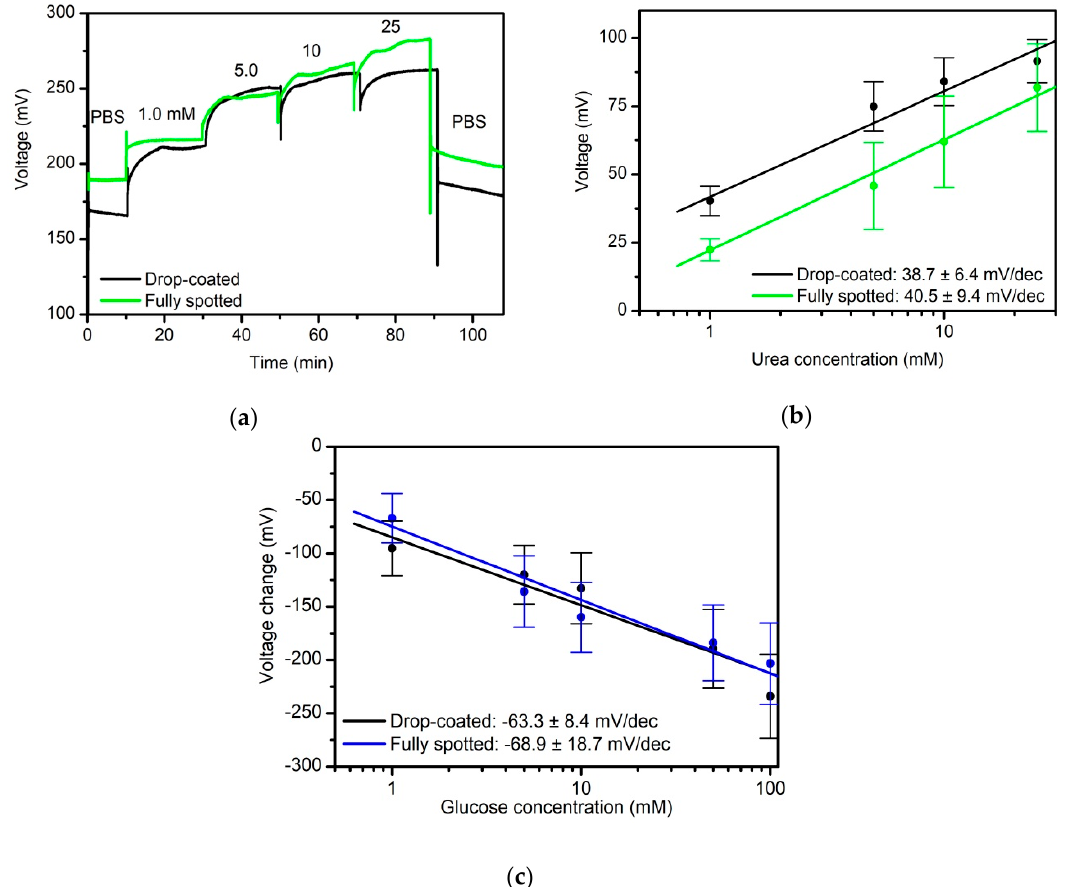
Figure 4. ( a ) ConCap response of EIS biosensor modified by the enzyme urease by drop-coating (black curve) and fully spotted (green curve) in PBS, pH 6.8, and urea solution of different concentrations from 1 mM to 25 mM; ( b ) corresponding calibration curves for both sensors; ( c ) calibration curves evaluated from ConCap response (data not shown) for the nano-spotted capacitive glucose oxidase-modified EIS biosensor (blue) and the drop-coated biosensor (black) recorded in PBS, pH 7.4, with different glucose concentrations from 1 mM to 100 mM.PBS: polymix multi-component buffer solution; numer of investigated sensors for each type N = 3.